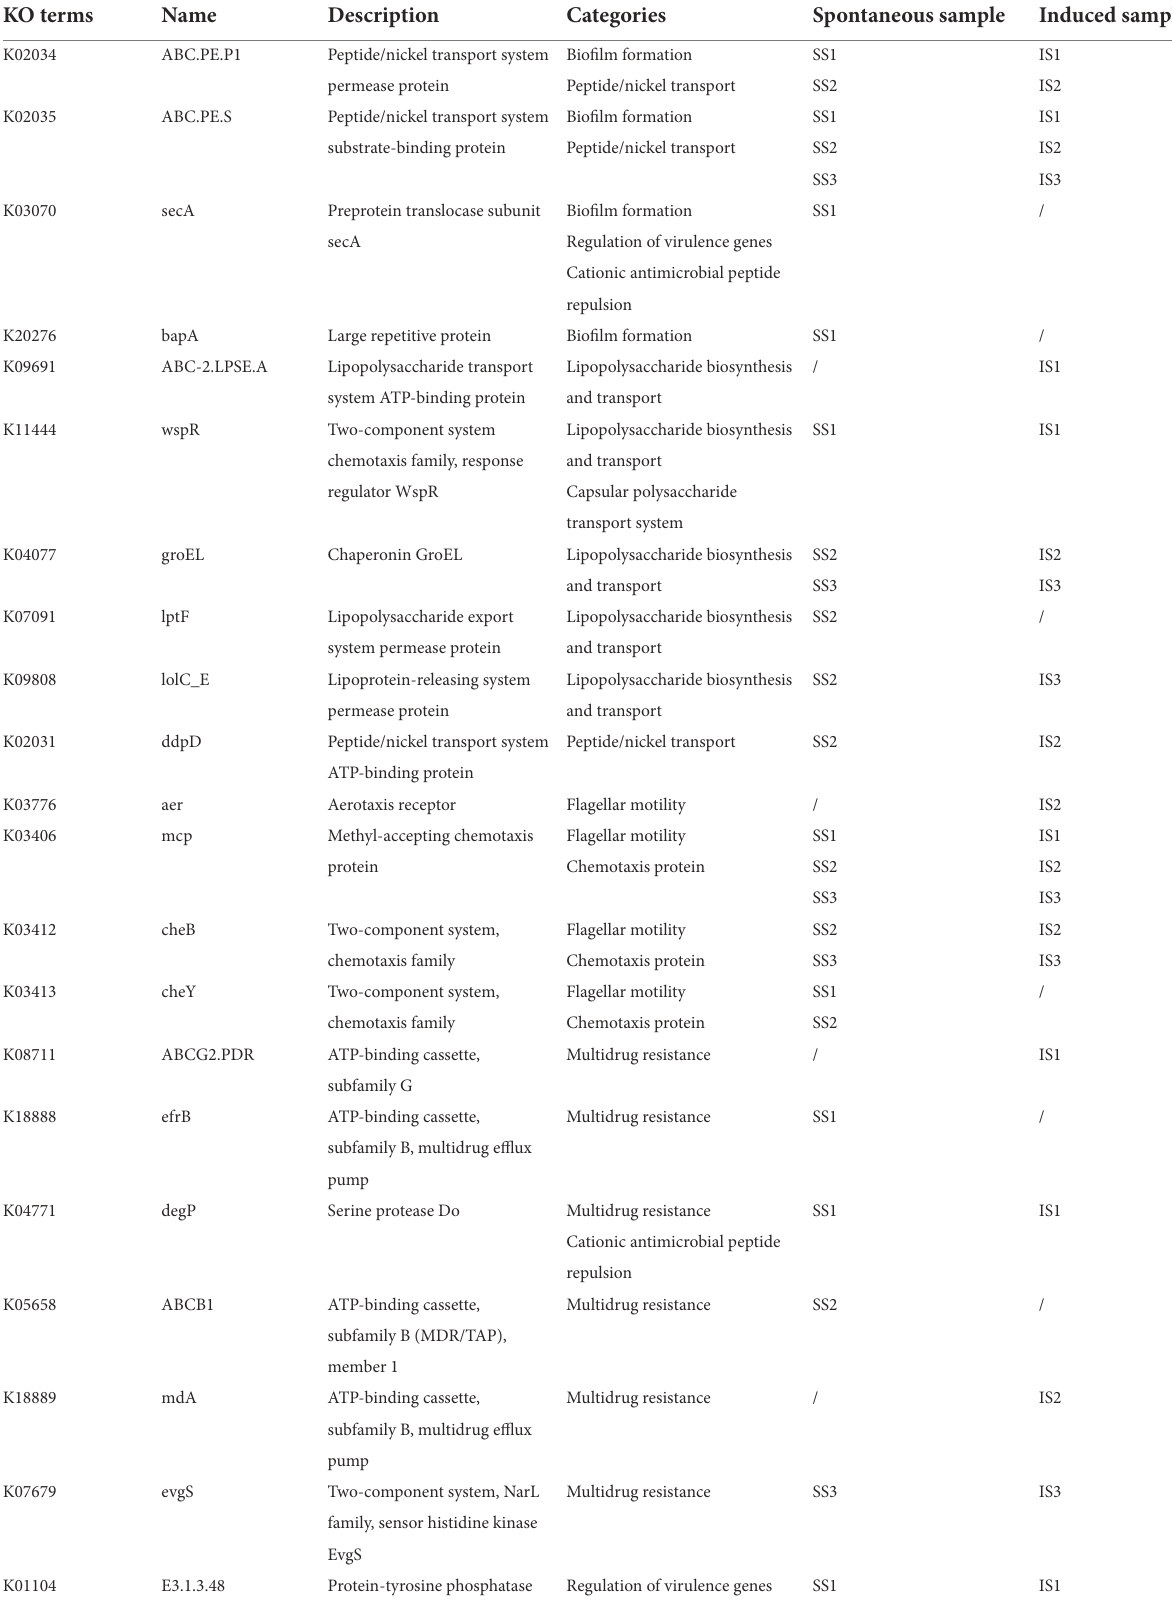
TABLE 5 Functional annotation of the microbial proteins of